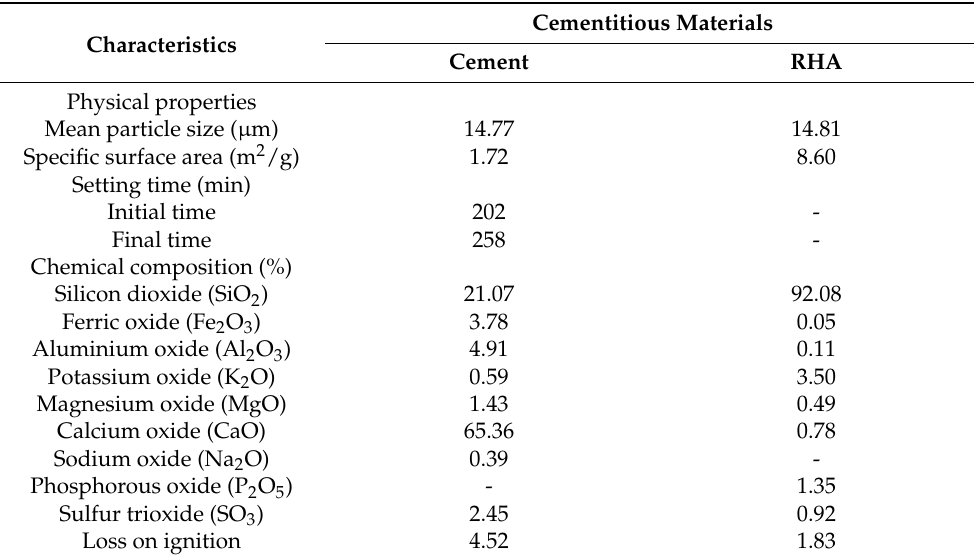
Figure 2. The particle size distributions of cement, RHA, river sand and RCA.